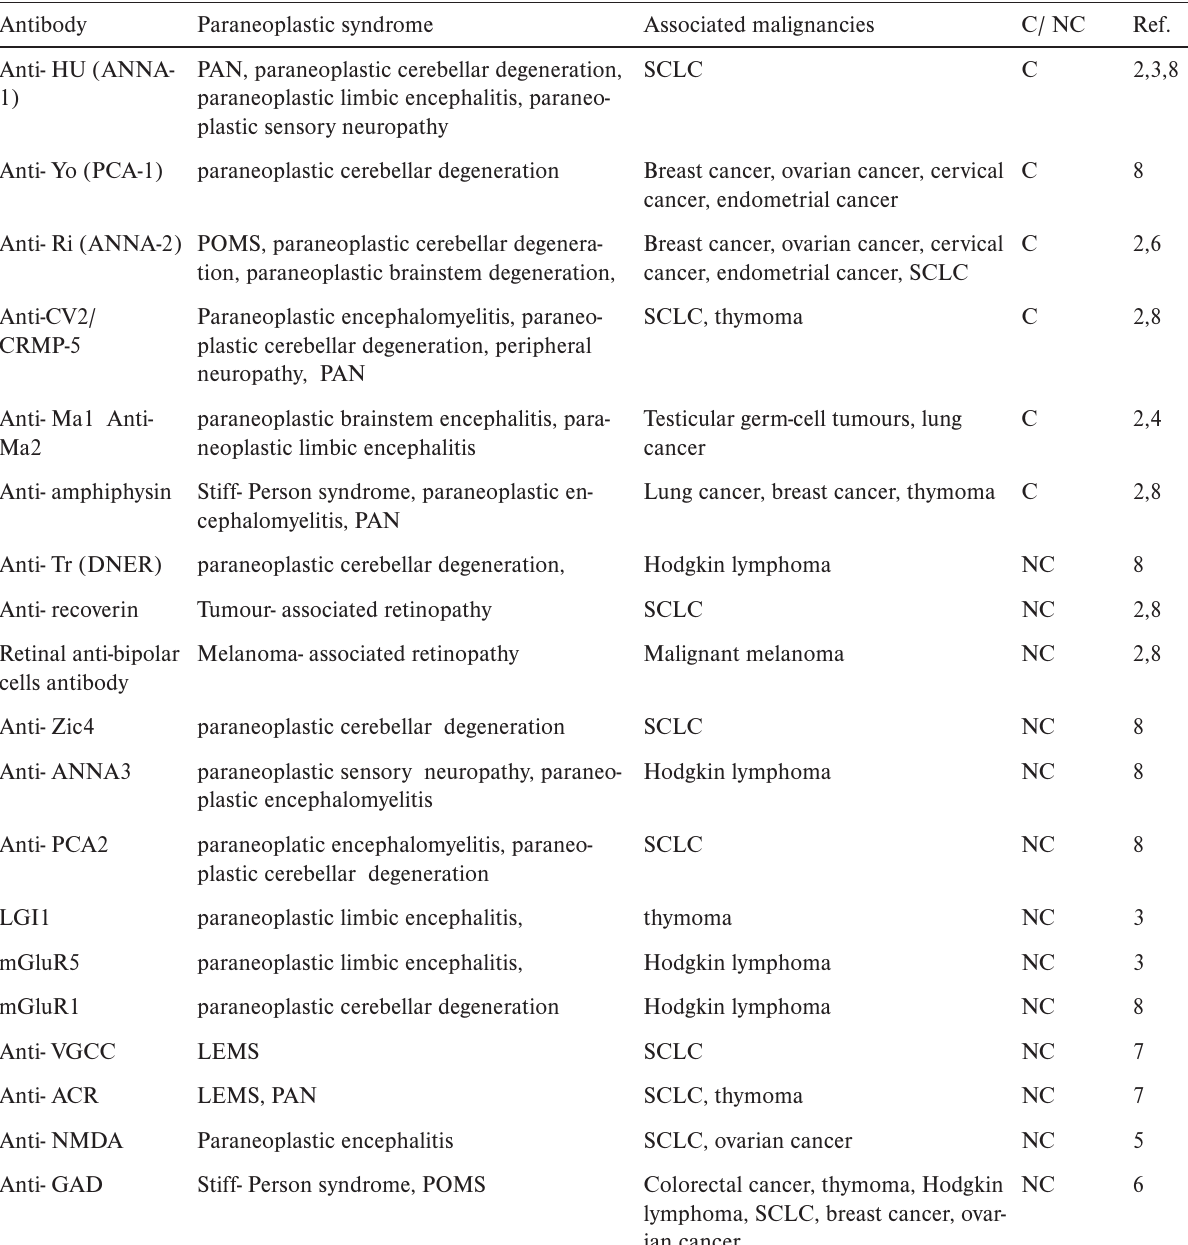
Table 1. OAs, their association with paraneoplastic syndromes and primary malignancies. Antibody Paraneoplastic syndrome Associated malignancies